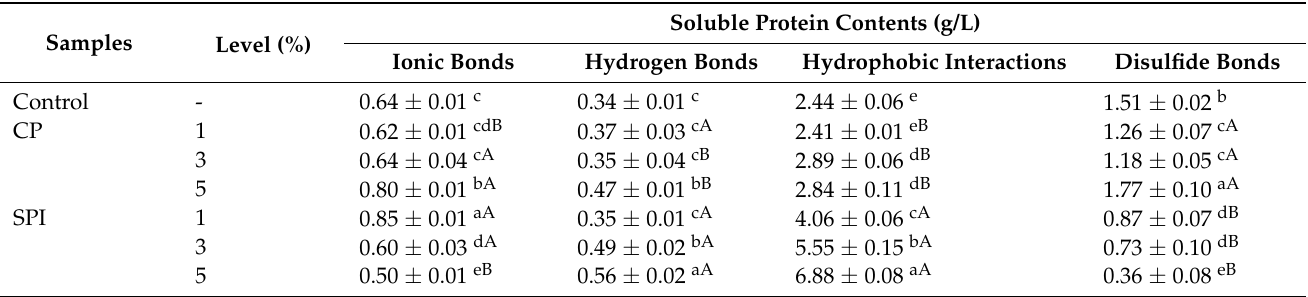
Table 2. Effects of the addition of cricket powder (CP) and soy protein isolate (SPI) on molecular driving forces of mackerel surimi